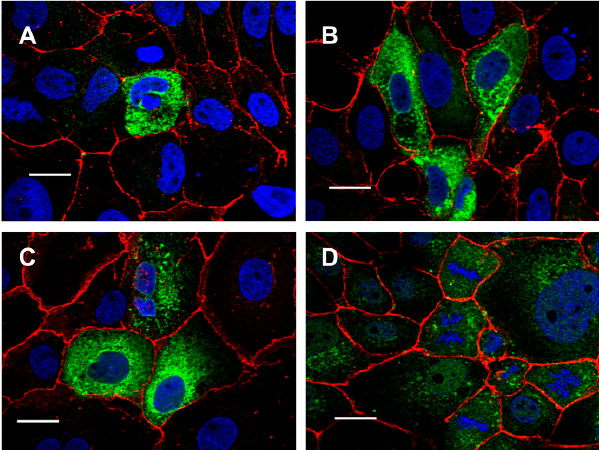
Figure 1. TMEM16E, -H, -J, and -K are expressed in intracellular compartments. Expression of ( A ) TMEM16E, ( B ) TMEM16H, ( C ) TMEM16J and ( D ) TMEM16K in FRT cells. His-tagged TMEM16E, - H, -J and -K proteins were detected with anti-His antibodies (green). β -catenin was visualized using an Alexa 568-labeled secondary antibody (red). Bar 20 µm.